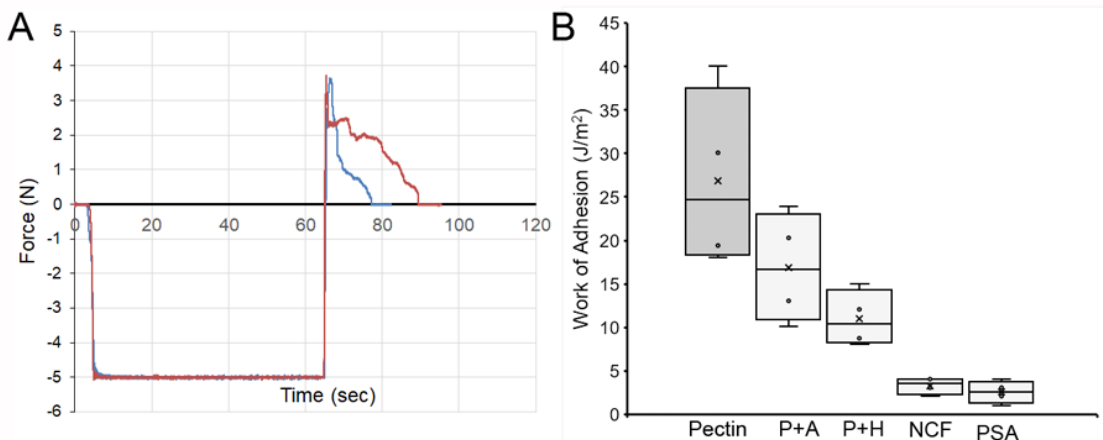
Figure 6. Mechanism of pectin adhesion to the porcine pleural glycocalyx. ( A ) Pectin adhesion to the native pleural surface (red line) and after enzyme treatment with hyaluronidase (blue line). The area under the curves reflect the work of adhesion. ( B ) Comparison of pectin adhesion to the native glycocalyx (dark gray) compared to the glycocalyx diminished by pleural abrasion (P + A) and hyaluronidase (P + H) pre-treatment (light gray). Nanocellulose fibers (NCF) and pressure-sensitive adhesive (PSA) are also shown for comparison. The box spans the interquartile range of the replicate samples with the median marked with an X and the whiskers defining the data